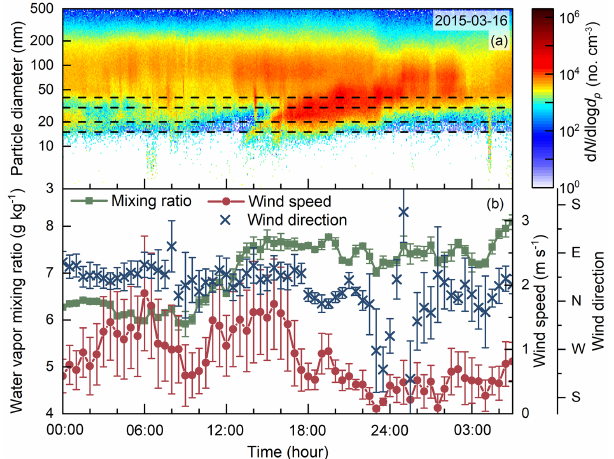
Figure 6. (a) The contour plot of aerosol size distributions of a typical type-B new particle formation event observed on 16 March 2015, at the Fukue Island site. The dashed lines indicate the analyzed particle diameters. (b) The time series of wind speed, wind direction, and water vapor mixing ratio. The error bars are the standard deviations.